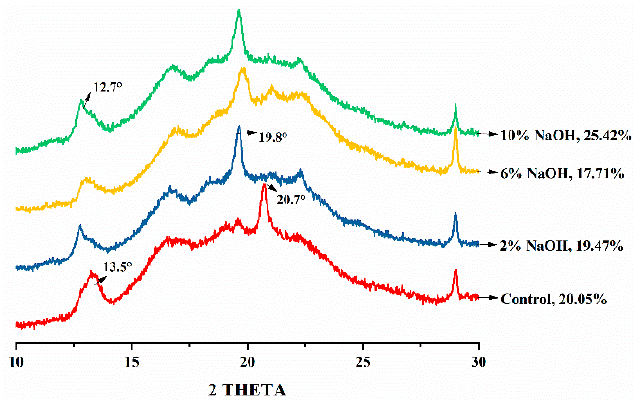
Figure 5. XRD patterns of HAS films treated with different concentrations of NaOH. The percentage in the figure is the crystallinity of the films.